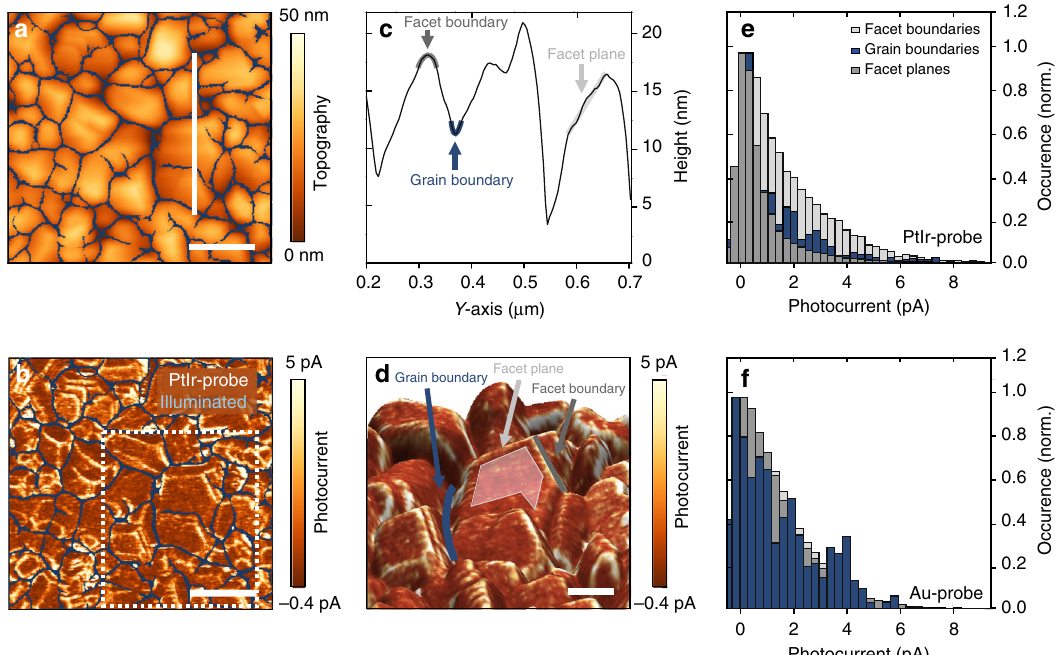
Fig. 2 Statistical analysis of the photocurrent distribution. a Topography image and b photocurrent map of a BiVO 4 thin fi lm using a PtIr-coated probe at an applied sample bias of 1.75 V. The grain boundaries are highlighted in blue. The spatially resolved photocurrent map is calculated by subtracting the current maps under illumination and under dark conditions. The scale bar is 200 nm. c Height pro fi le along the white perpendicular solid line shown in a de fi nes facet planes, as well as grain and facet boundaries. d 3D-topography image with overlaid photocurrent contrast. A representative facet plane is highlighted in light gray, grain boundary in blue, and facet boundary in dark gray. e , f Histograms of the photocurrent distributions at facet planes, facet boundaries, and grain boundaries. Histograms shown in e , f are extracted from b and Supplementary Fig. 11d, respectively. Similar distributions are observed in different maps taken in different sample areas. While the current distributions obtained with Au-coated probes show homogenous current distribution across all three regions, the current distributions obtained with PtIr-coated probes exhibit a signi fi cantly enhanced photocurrent at facet